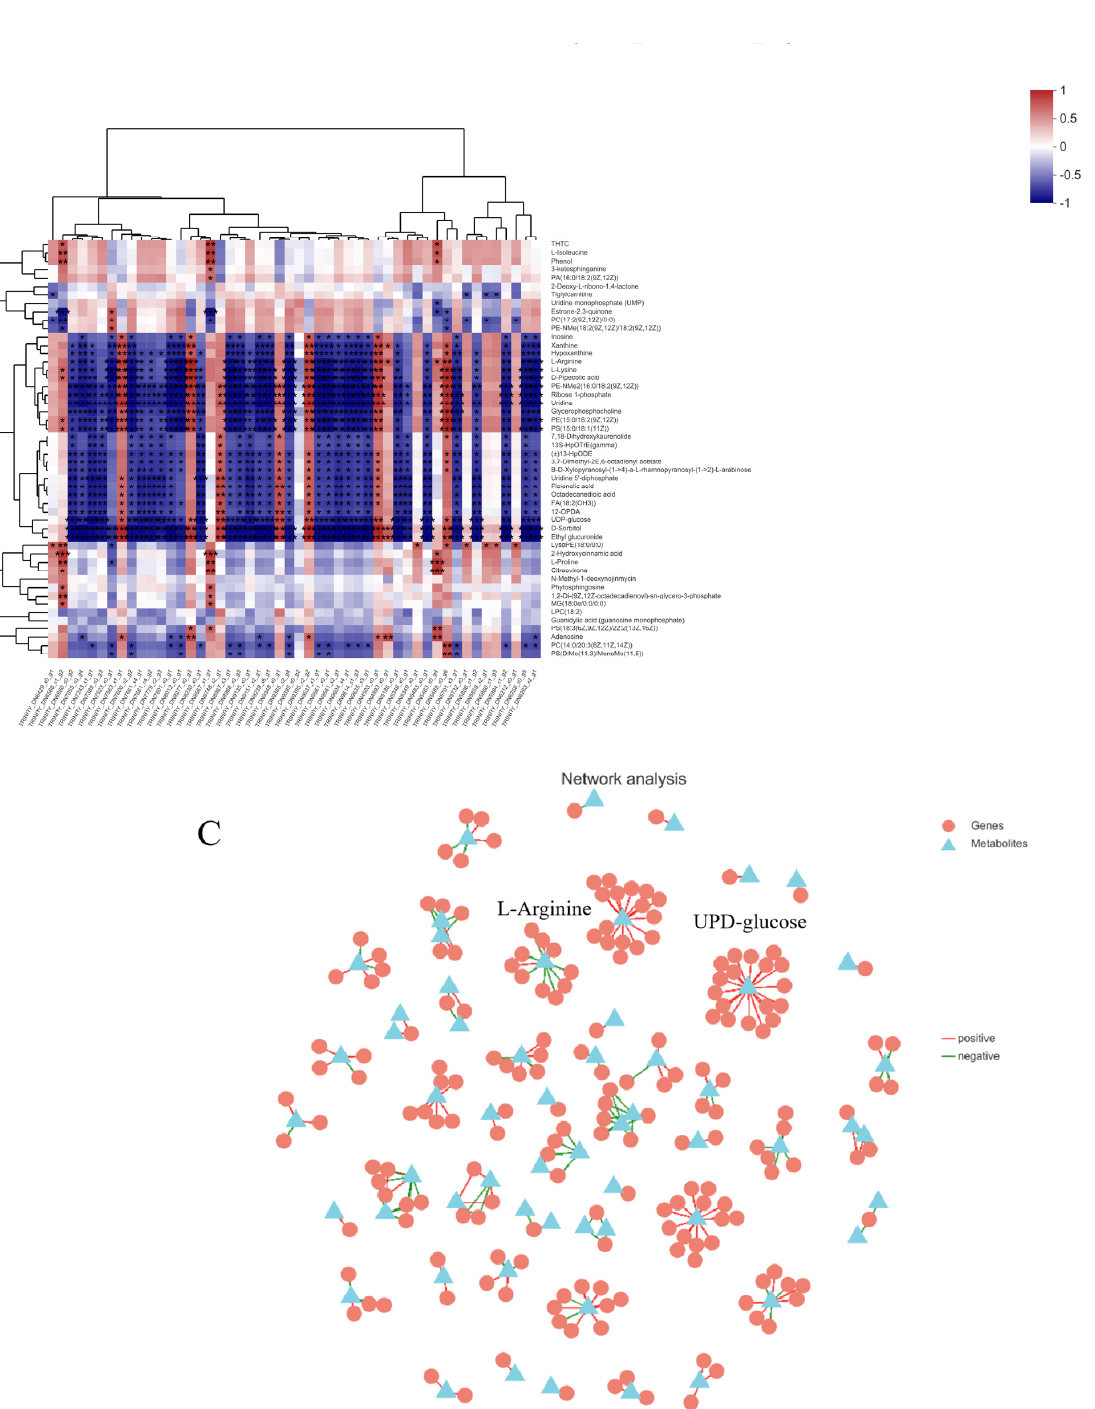
Figure 6. Correlation analysis of DEGs and DEMs between SEPS_48 and GEPS_48 comparison groups. ( A ) Correlation analysis of SEPS_48 and GEPS_48 KEGG pathway annotation histogram (the color represents pathways, and the size of the bubble represents the number of enriched genes or metabolites). ( B ) Heat map correlation analysis between DEGs and DEMs. *, p < 0.05. **, p < 0.01. ***, p < 0.001. The red and blue depths represent the strength of the positive and negative correlations, respectively. ( C ) Correlation network of DEGs and DEMs. Triangle represents metabolites, circle represents genes, connecting line represents correlation coefficient, red line represents positive correlation (correlation coefficient > 0), green line represents negative correlation (correlation coefficient < 0), and the thickness of the connecting line corresponds to the absolute value of the correlation